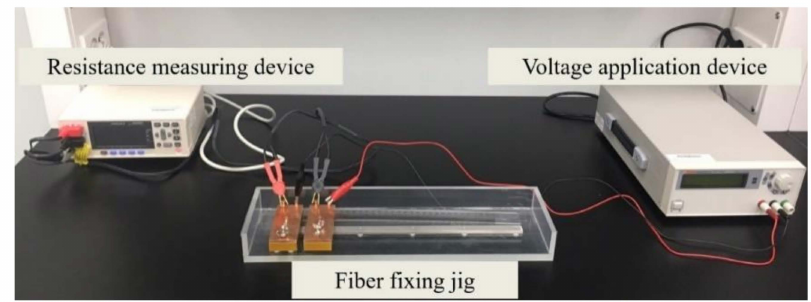
Figure 3. Device for measuring the fiber